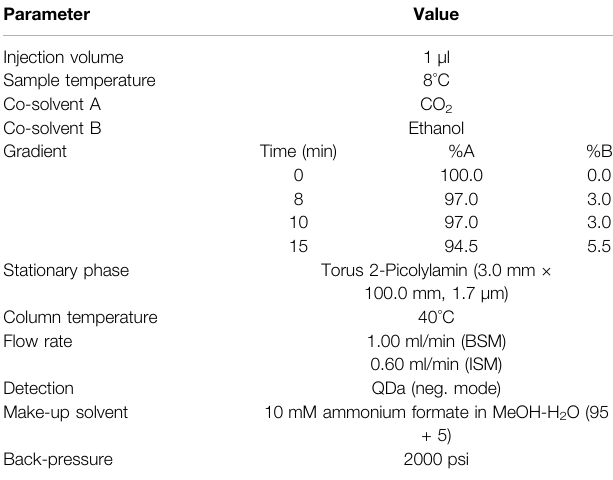
TABLE 1 | Optimized UHPSFC method settings. Parameter